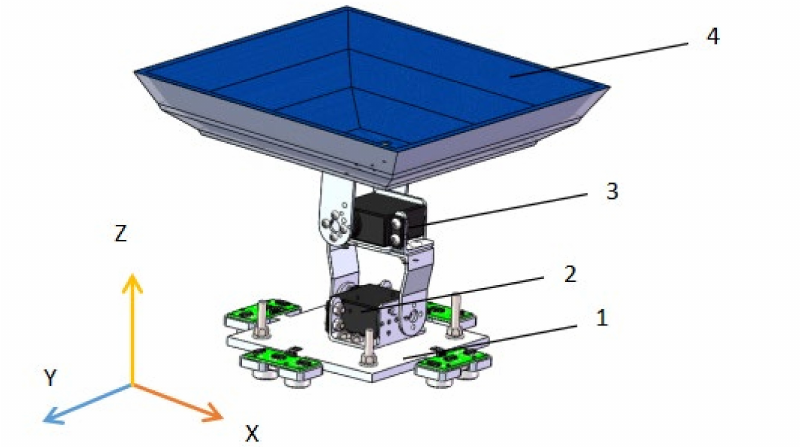
Figure 3. Two-degree-of-freedom parallel platform. 1. Base, 2. Lower steering gear, 3. Upper steering gear, 4. Waste identification